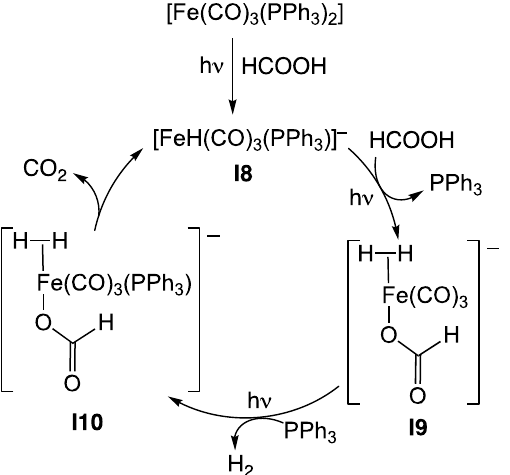
Scheme 4. Catalytic cycle proposed for the dehydrogenation of FA with [Fe(CO) 3 (PPh 3 ) 2 ] in situ generated from the mixture [Fe 3 (CO) 12 ]/PPh 3